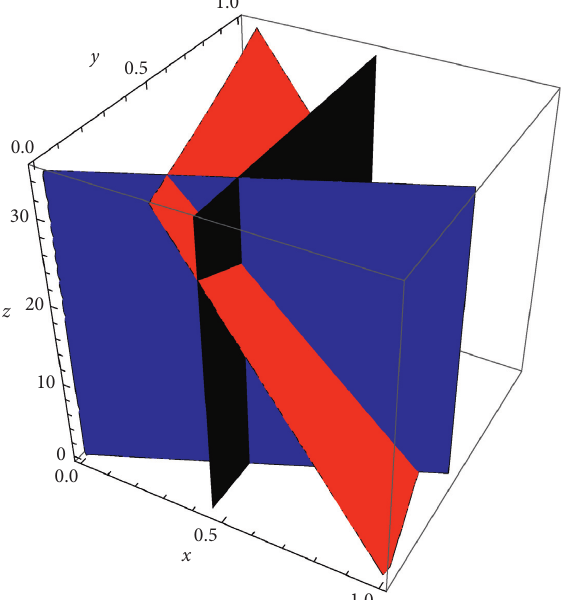
Figure 3: Stability region of E ∗ in abc